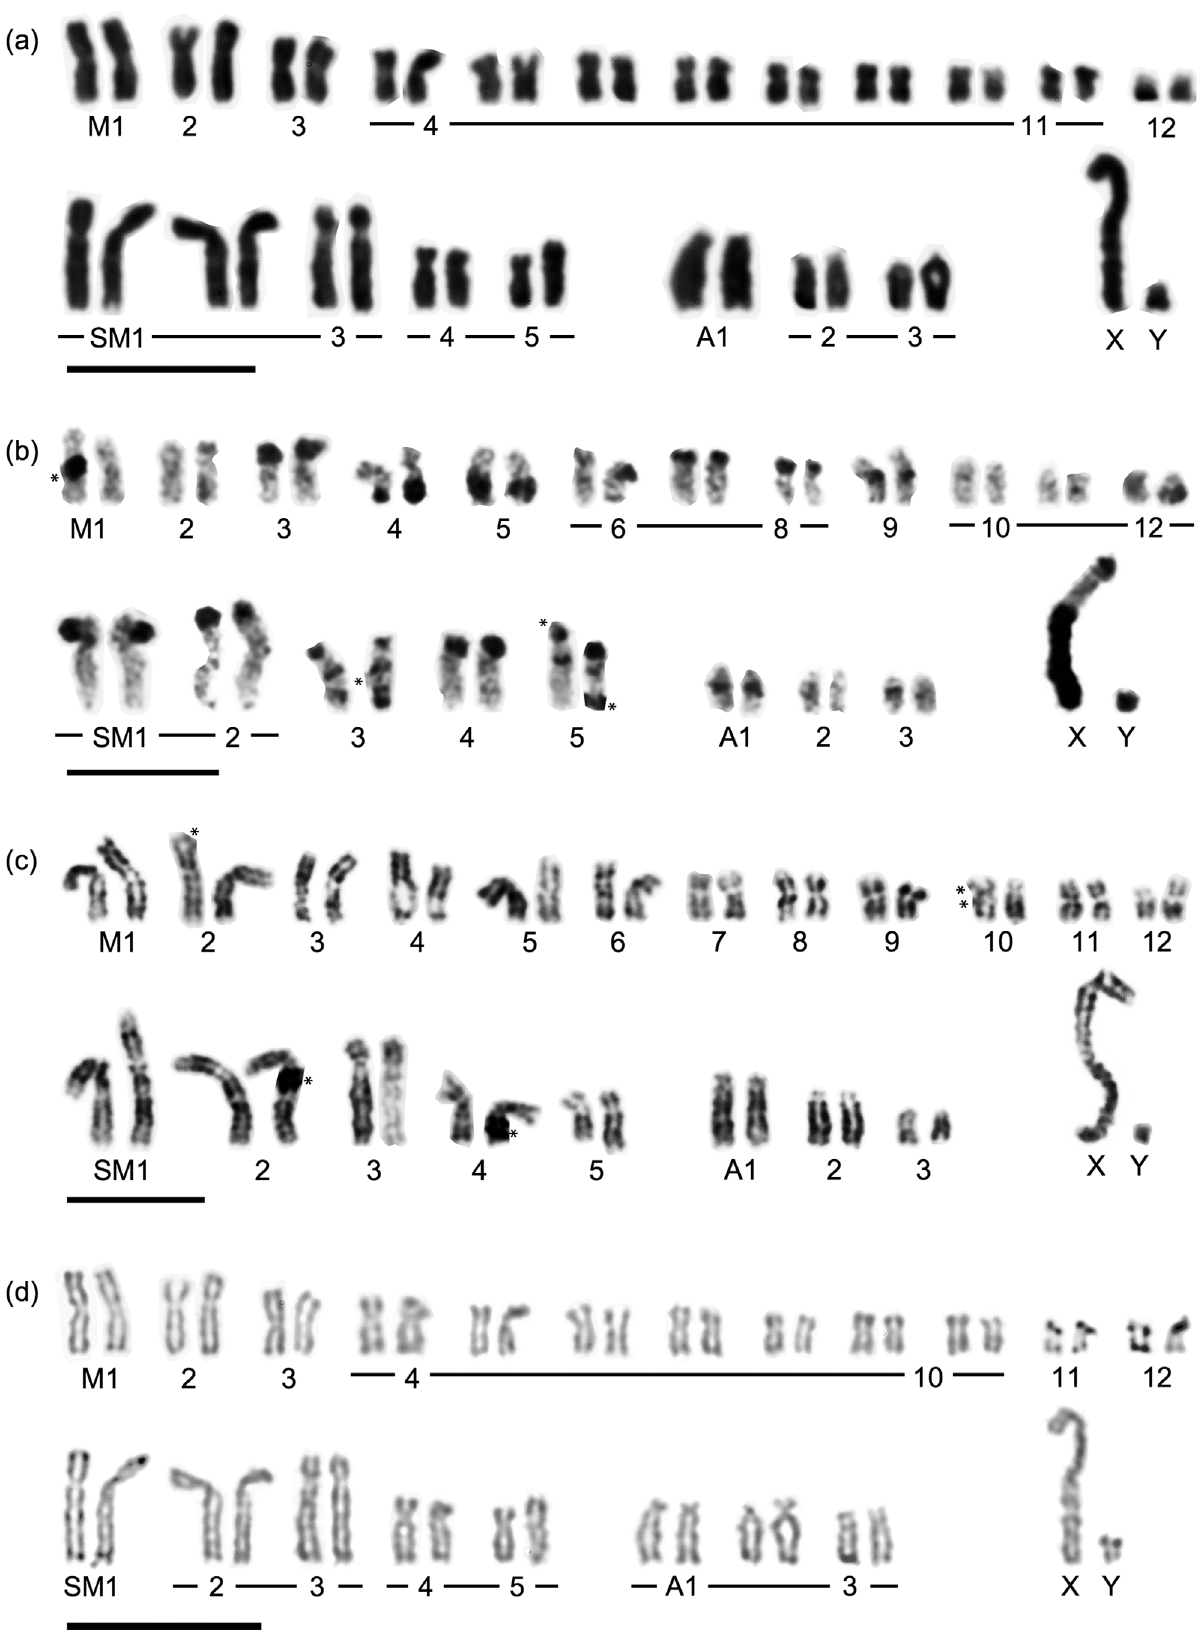
Figure 3 - Conventional (a), C-banding (b), G-banding (c), and NOR-banding karyotypes (d) of M. carlhubbsi . Bar = 10 (cid:2)